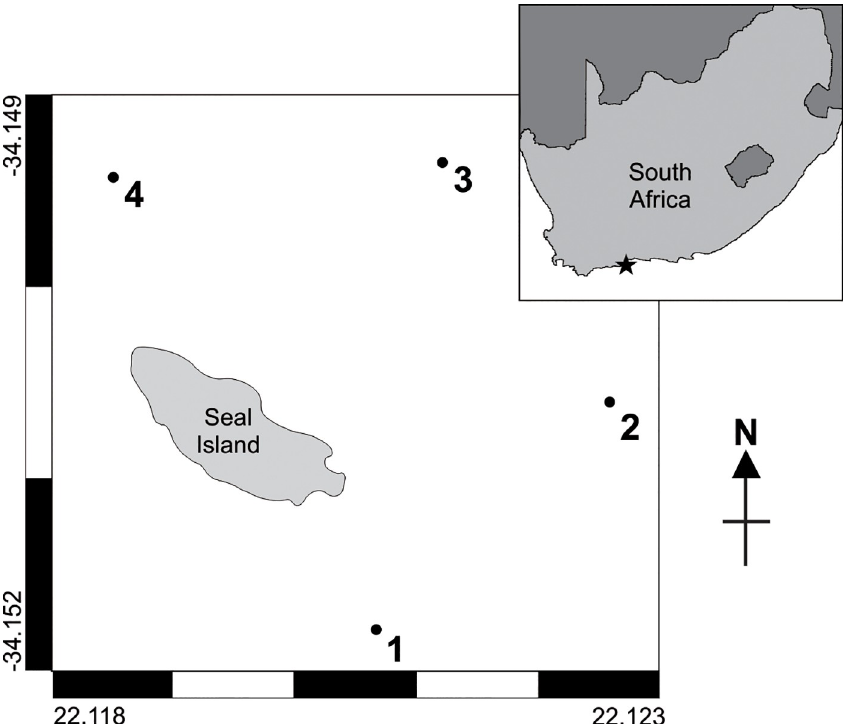
Fig 1. Map of Seal Island (A) in Mossel Bay, South Africa (B), highlighting the specific location of testing sites around the island (A1-4). Testing site locations are not exact, but, instead, mark the approximate area that trials were concurrently